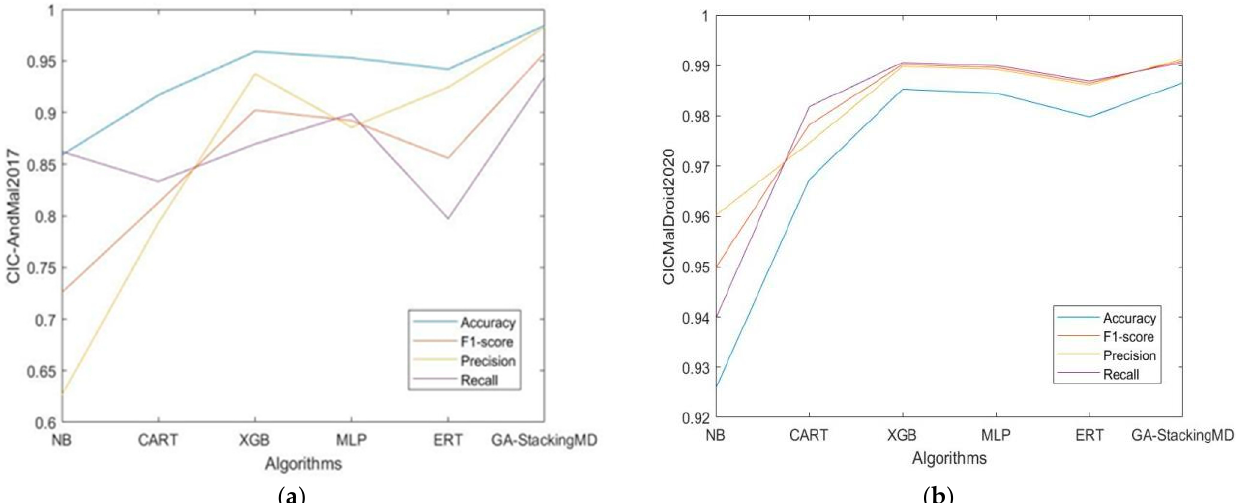
Figure 7. ( a ) CIC-AndMal2017: Comparison of GA-StackingMD and other classifiers; ( b ) CICMal- Droid2020: Comparison of GA-StackingMD and other classifiers.